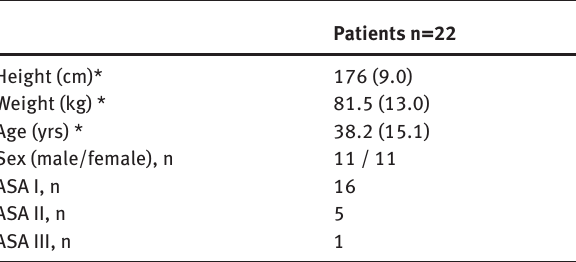
Table 2: Patient characteristics and process times (*mean ± SD)